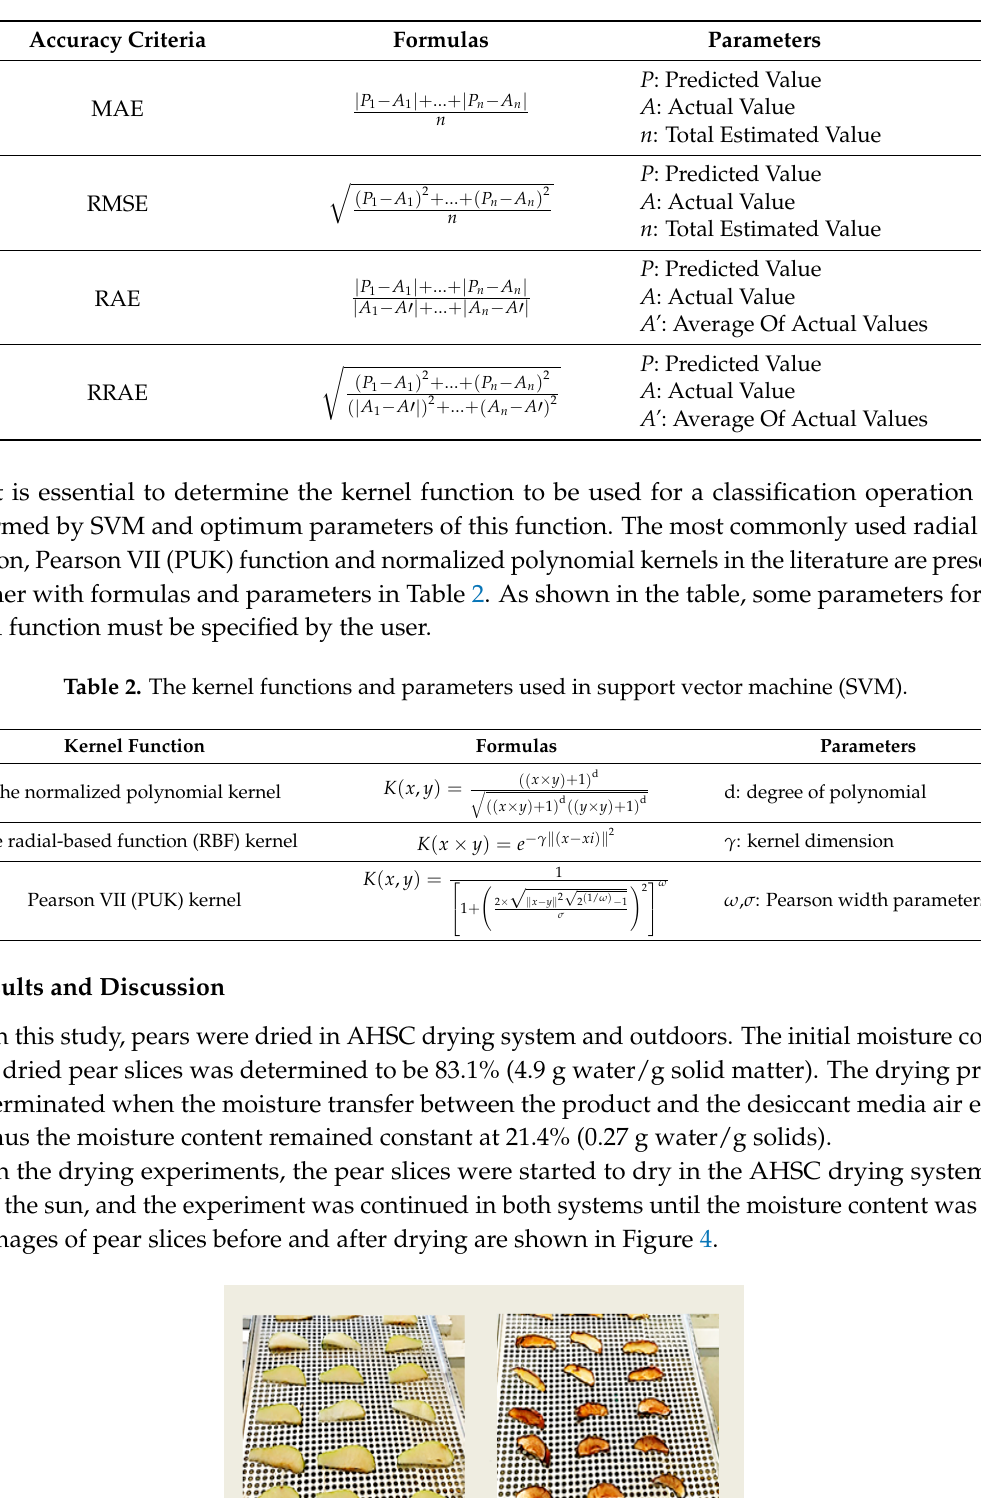
Table 1. Accuracy Criteria and Formulas.